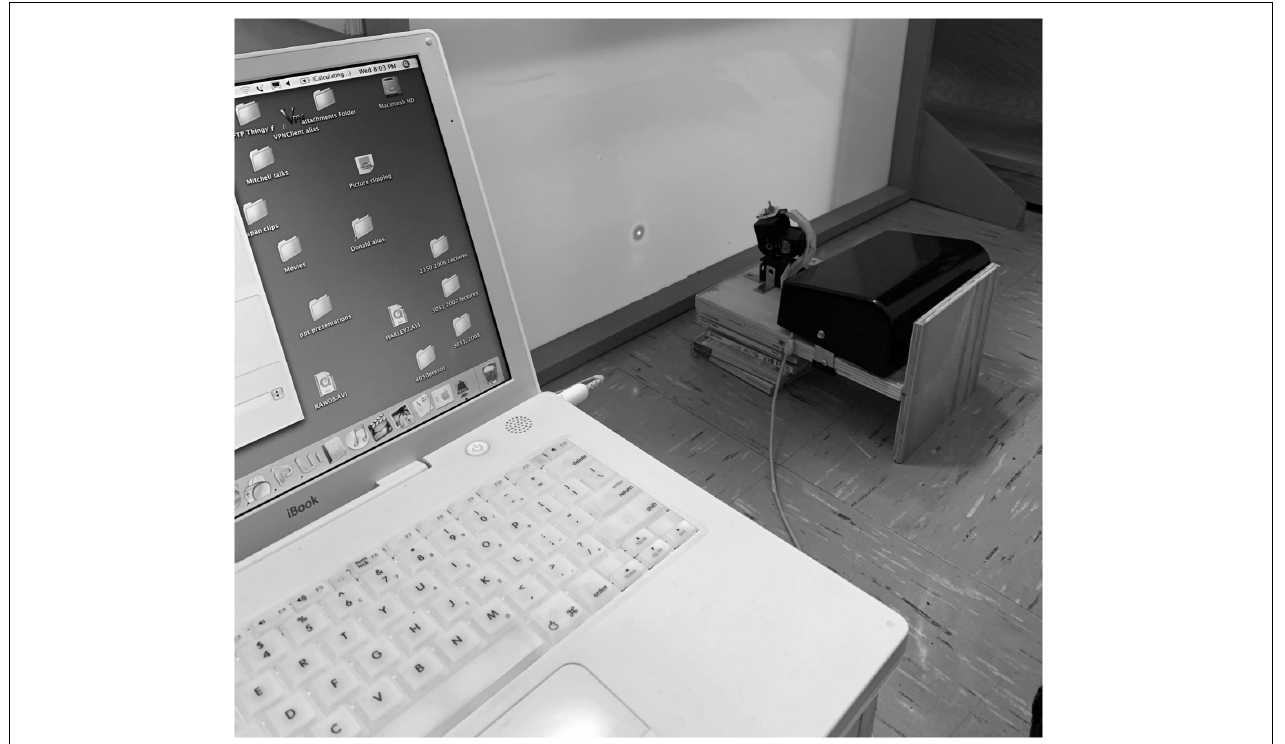
FIGURE 2 | A photograph of the set-up used to project moving laser spots on the wall or floor of the arena. Note the expanded diameter (5 mm) of the laser spot due to scatter by the translucent screen upon which it is